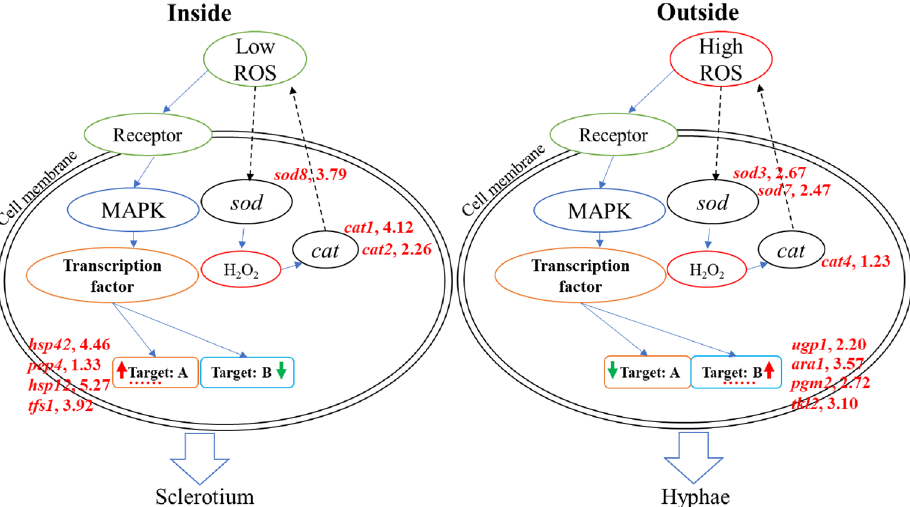
Figure 8. Model of morphogenesis caused by different ROS stress at sclerotial initiation stage in M. importuna . The receptor in the cell membranes receives signal and transmits to kinases that control the expression of transcription factors and downstream genes. Differential expression of H 2 O 2 -producing genes ( sod ) and H 2 O 2 - scavenging genes ( cat ) resulted in different H 2 O 2 concentrations in SII and SIO. Some target genes of MSN2 (group A) showed upregulated expression in the sclerotium (inside), while others (group B) were up-regulated in hyphae (outside). Finally, Different morphogenesis (sclerotium formation in SII and hyphae growth in SIO) occurred. Genes marked with red indicated upregulation and of log2 (Fold Change) value was followed. Red and green arrows indicate upregulation or downregulation of expression, respectively. Black dotted arrows indicated unknown process. Ellipsis indicated unshown